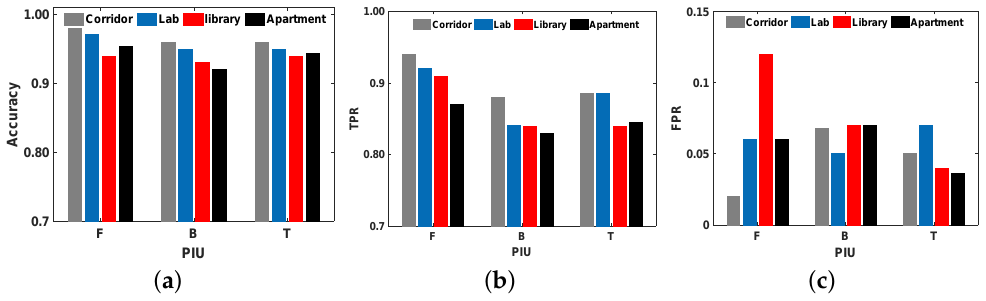
Figure 12. Under different environments. ( a ) Segmentation accuracy under different environments; ( b ) True positive rate under different environments; ( c ) False positive rate under different environments.